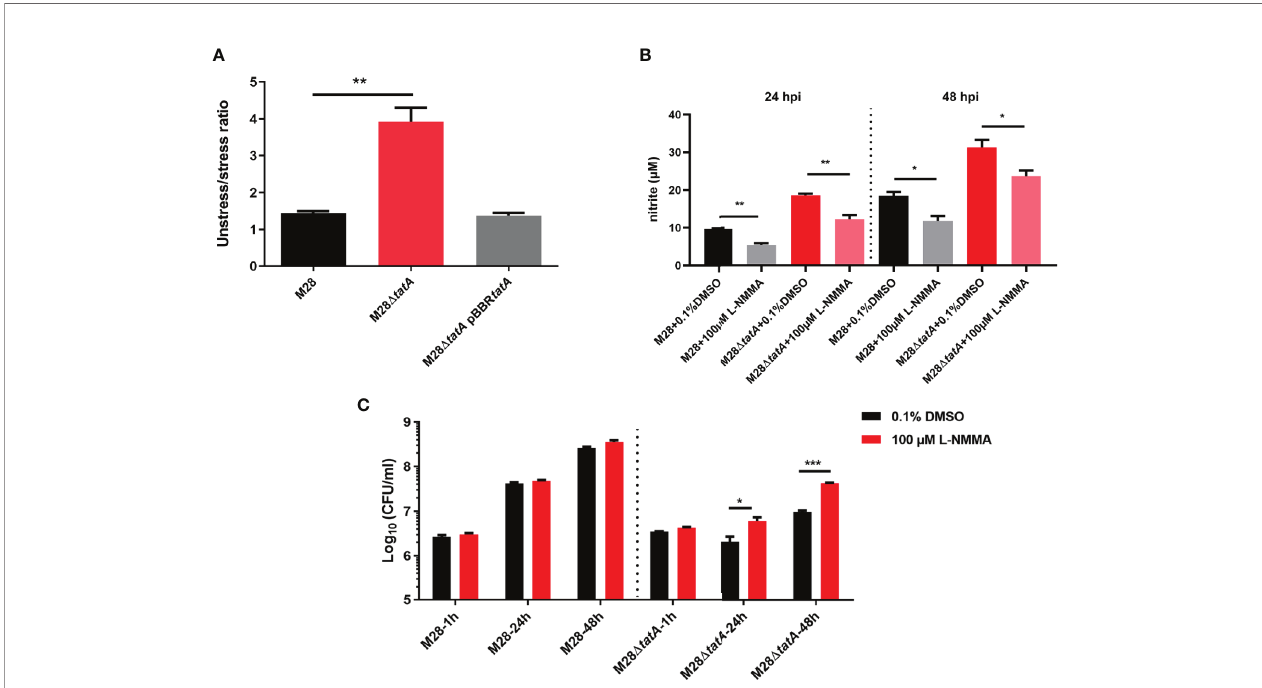
FIGURE 6 | Sensitivity of various B. melitensis M28 strains to nitrosative stress and inhibition of NO production increases the intracellular survival of Tat mutant Brucella . (A) Nitrosative stress survival assay. Serially diluted cultures of the wild type, M28 D tatA mutant, and complemented strain were spotted on plain TSA plates or TSA plates containing NaNO 2 (5 mM). After 72 h of growth at 37°C under 5% CO 2 , CFUs were counted, and the ratio of CFUs on the TSA plain plates (CFU unstressed ) to CFUs on the NaNO 2 -supplemented TSA plates (CFU stressed ) was calculated for each strain. (B) L-NMMA treatment reduced NO production in M28- and M28 D tatA -infected RAW264.7 cells. (C) L-NMMA treatment increased Tat mutant Brucella intracellular survival in RAW264.7 cells at 24 h and 48 h post infection; the data are shown as the mean ± standard error of the mean. Student ’ s t test was used to evaluate signi fi cant differences between the M28 D tatA mutant and the wild type. *p < 0.05; **p < 0.01; ***p <